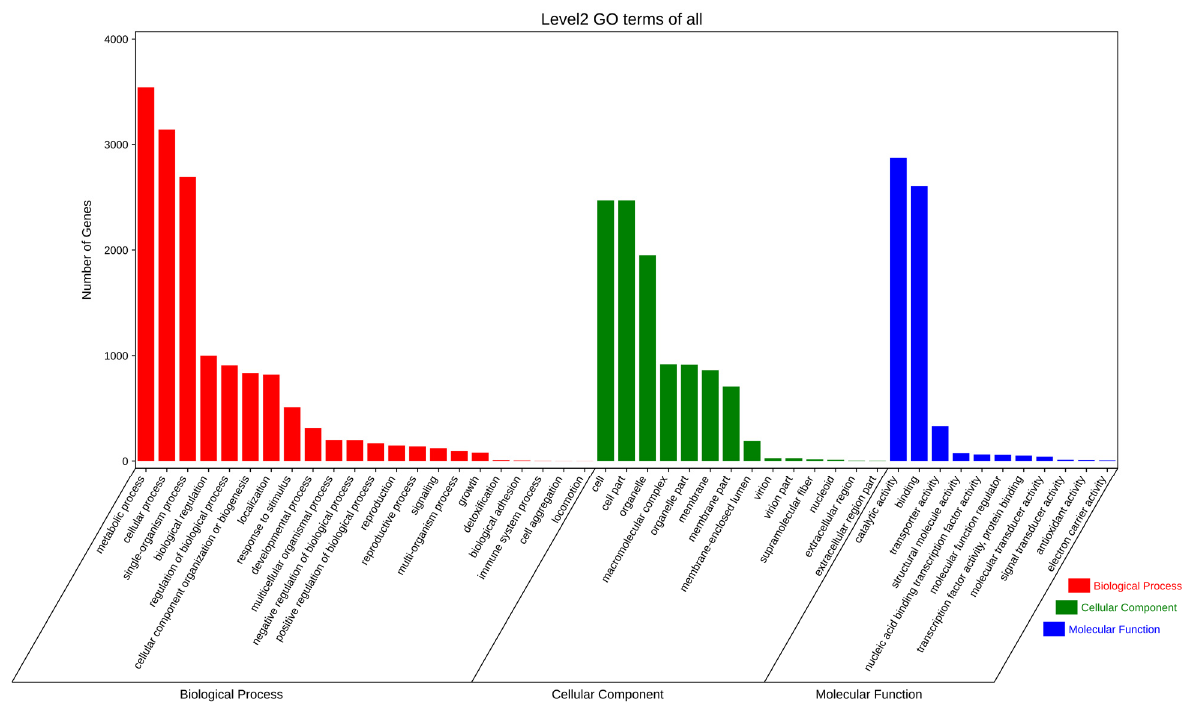
Figure 7. Gene Ontology(GO) functional annotation of B. zeicola LWII .